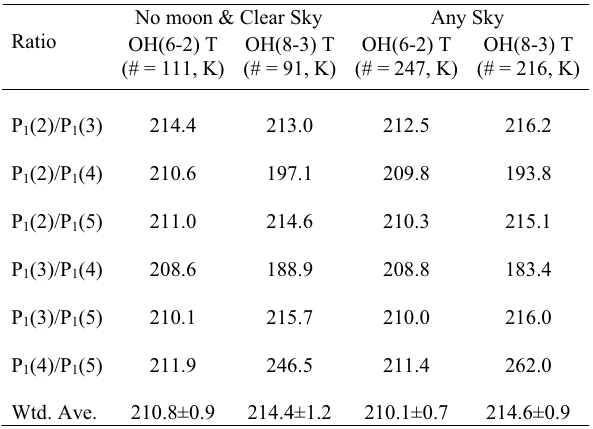
Table 5. Average hydroxyl rotational temperatures for individual line ratios in the OH(8–3) and OH(6–2) bands over the 1990 win- ter (106 ≤ day-of-year ≤ 258), separately presented for “no Moon and clear sky” and “any sky” conditions. Standard errors are listed for the “weighted average”